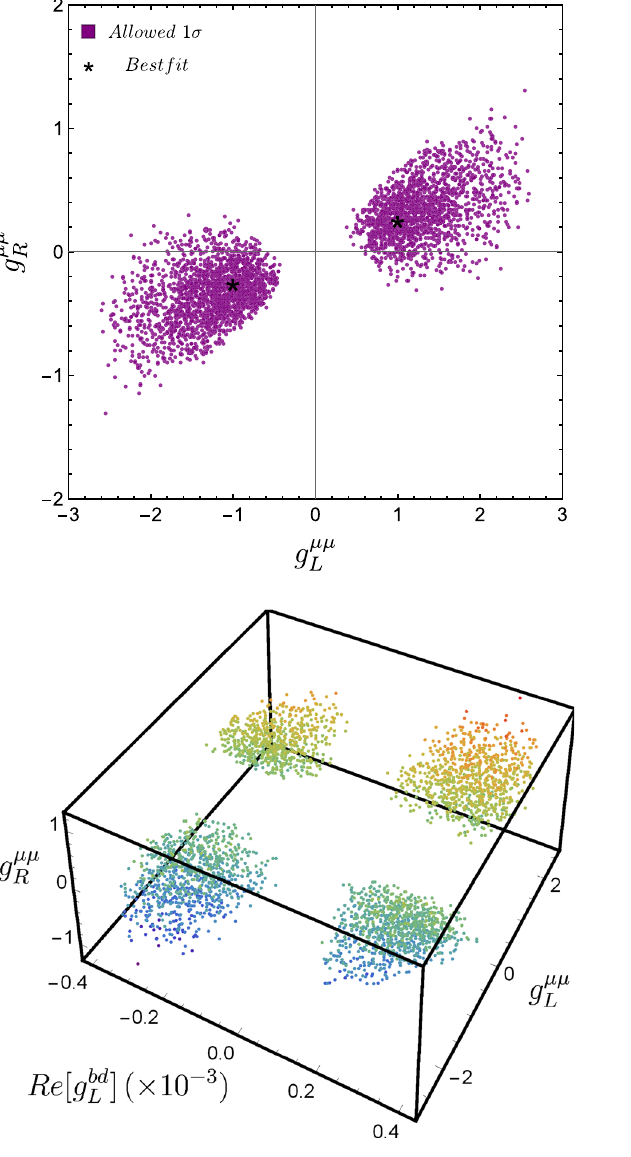
Fig. 5 The 1 σ -favored (Re[ g bd the bottom left 3D parameter space correspond to decreasing values of g